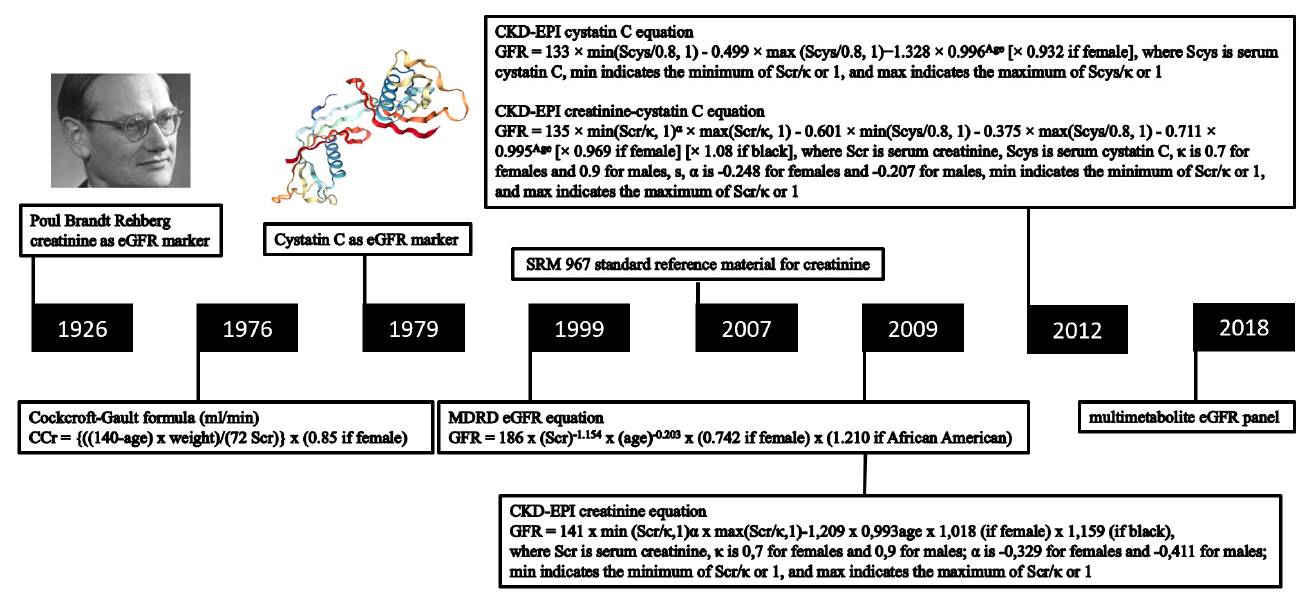
Figure 1. Overview of key moments in the development of GFR equations with endogenous filtration markers.